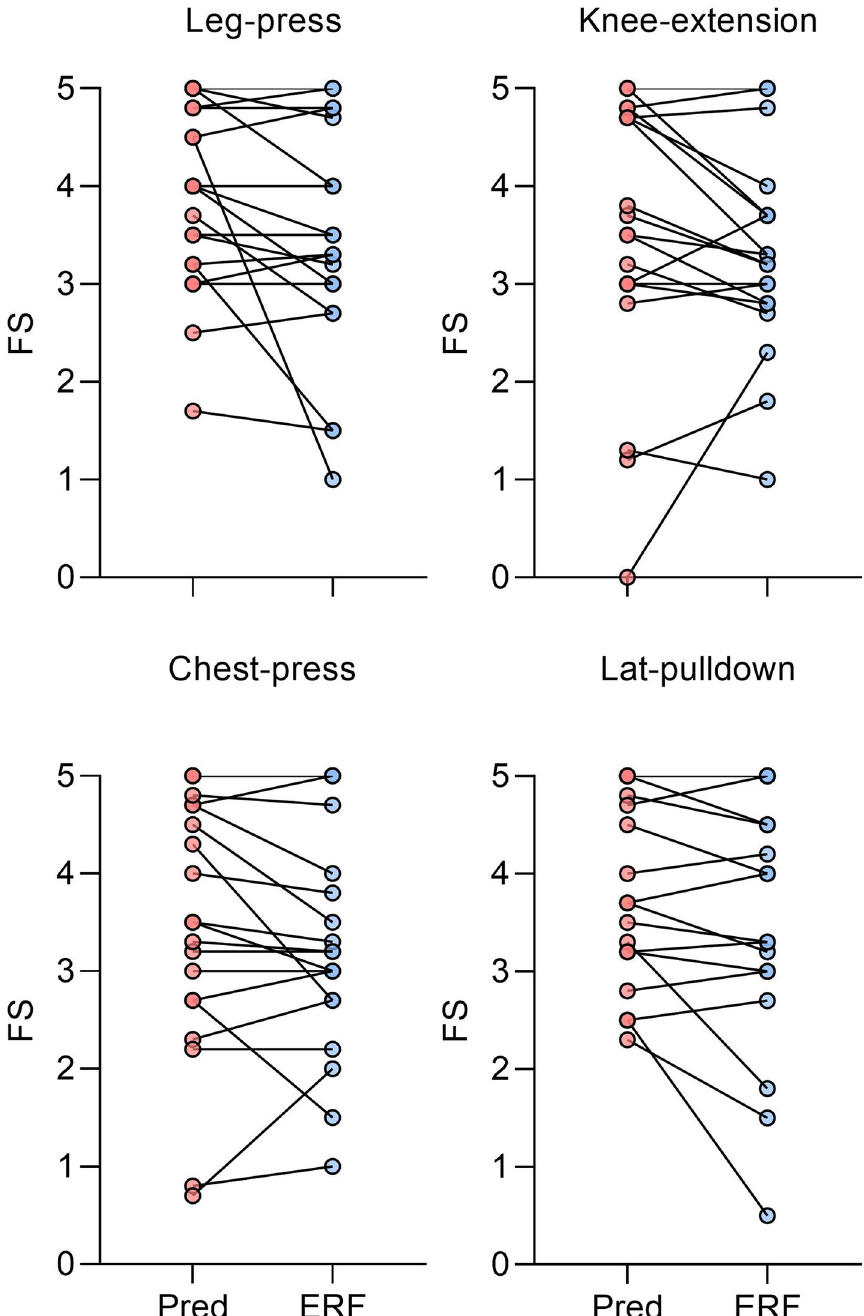
Fig 1. Mean FS scores (pre and post sets) of each exercise between experimental condition. Note that n = 20 for the leg-press and chest-press and n = 19 for the knee-extension and the lat-pulldown. ERF- Estimated Repetitions to Failure; Pred- Predetermined; FS- Feeling Scale